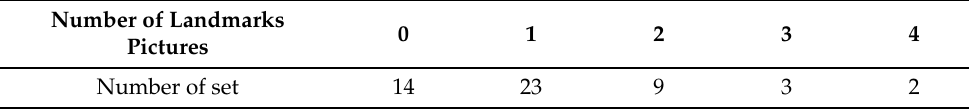
Table 6. Classifying sets by number of landmark pictures. Number of